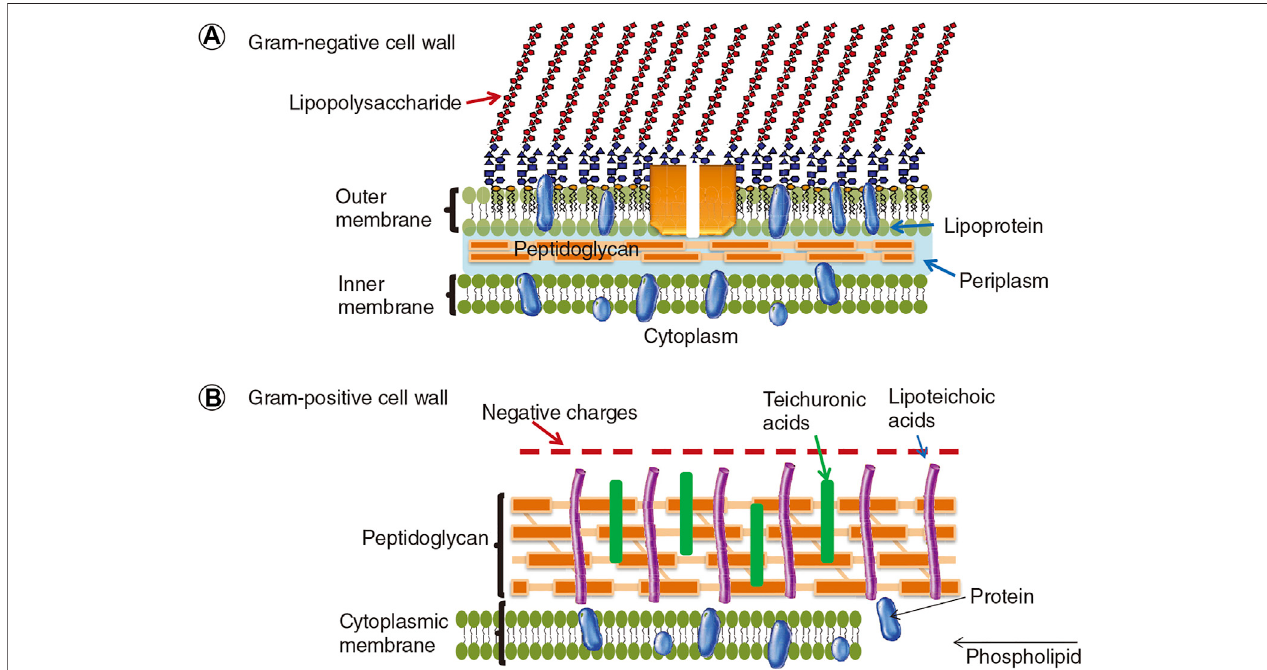
FIGURE 10 | The cell walls of Gram-negative and Gram-positive bacteria. Reprinted with permission from Yin et al. (2015).